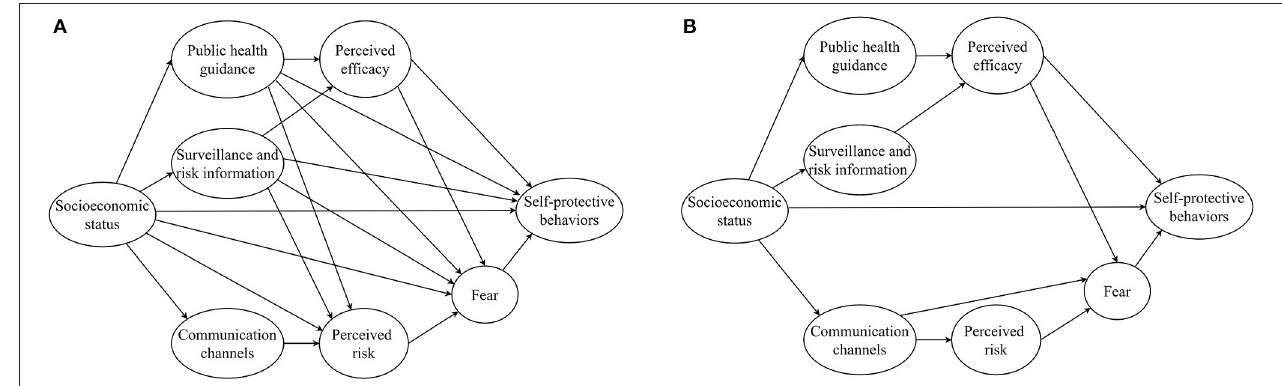
FIGURE 1 | Basic and parsimonious model to map the associations between socio-economic status, exposure to COVID-19-related information, psychological response during COVID-19, and self-protective behaviors in response to COVID-19. (A) The basic model. (B) The parsimonious model. (Data source: Authors’